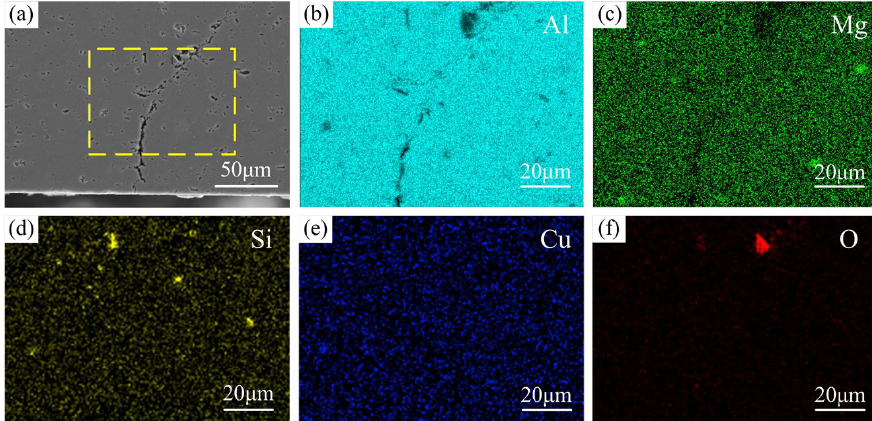
Figure 8. EDS mapping of a typical incomplete-penetration defect (obtained at d = 12 mm, ω = 600 rpm, and v = 30 mm/min): ( a ) SEM image; ( b – f ) EDS images showing the elemental distributions of Al, Mg, Si, Cu, and O in the selected area by the yellow dotted line in ( a ).